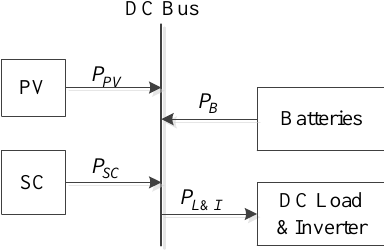
Figure 5. System structure of a single distributed storage system with storage batteries.